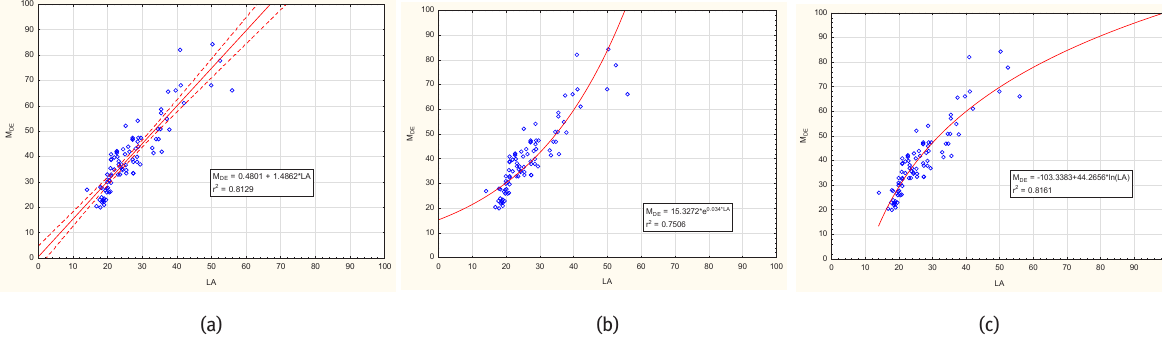
Fig. 9. Function fitting for Krosno sandstone: (a) linear, (b) exponential and (c) logarithmic Figure 10: Function fitting for all tested sandstones: (a) linear, (b) exponential and (c) logarithmic.